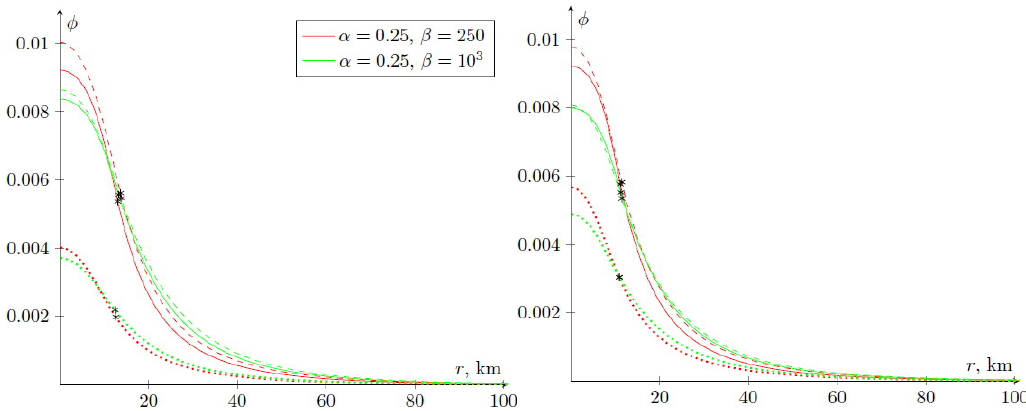
Figure 4. Dependence of scalar field on the radial coordinates using GM1 (left panel) and APR EoS (right panel) for some values of central density and parameter β in comparison with general relativity for α = 0.25. Solid, dashed and dotted lines correspond to (cid:101) c = 800, 500, 200 MeV/fm 3 (GM1) and (cid:101) c = 900, 650, 400 MeV/fm 3 (APR)